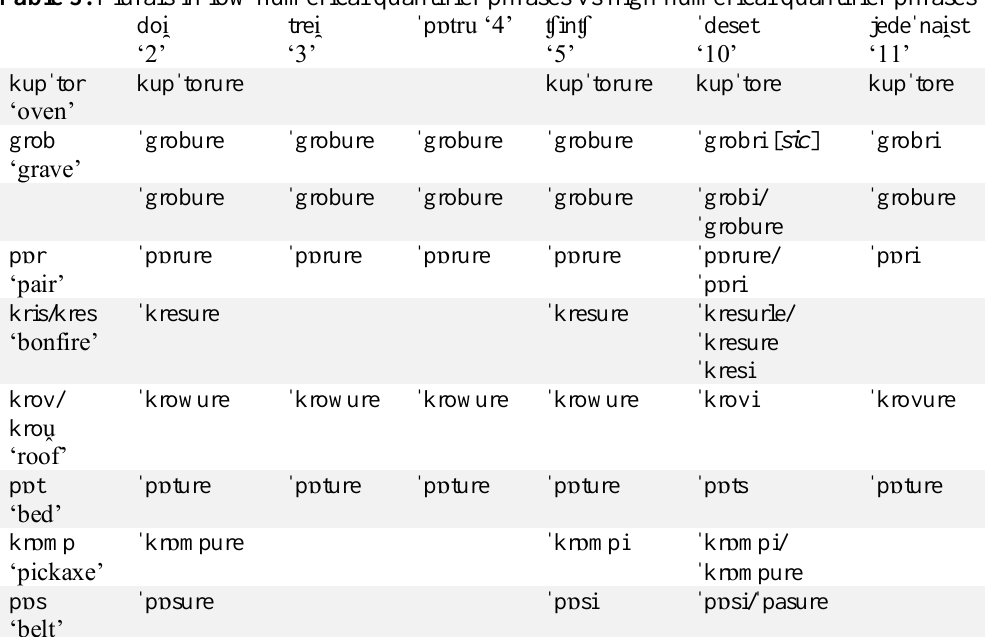
Table 3. Plurals in low numerical quantifier phrases vs high numerical quantifier